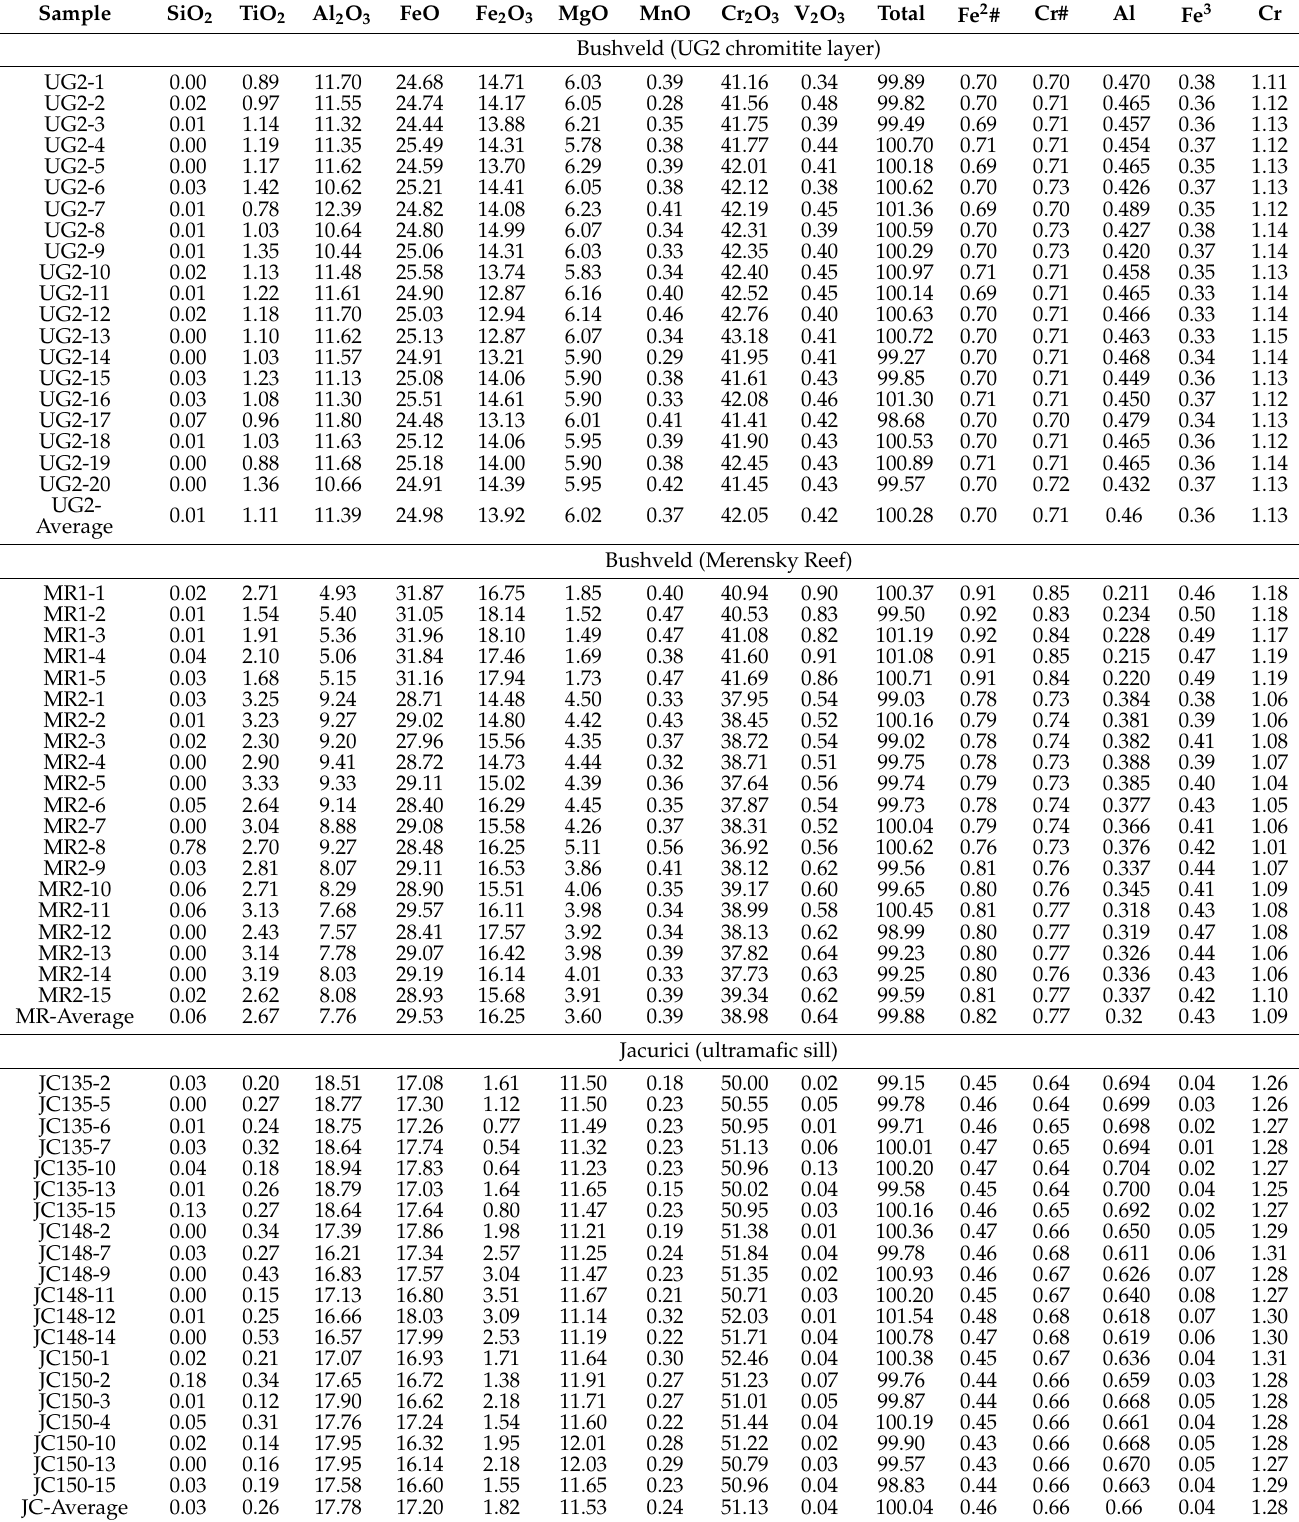
Table 2. Selected microprobe analyses (wt%) of chromite from rutile-bearing chromitites.